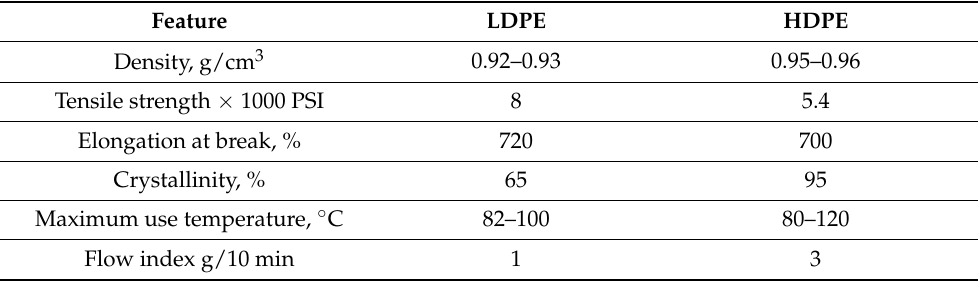
Table 1. Physical Characteristics